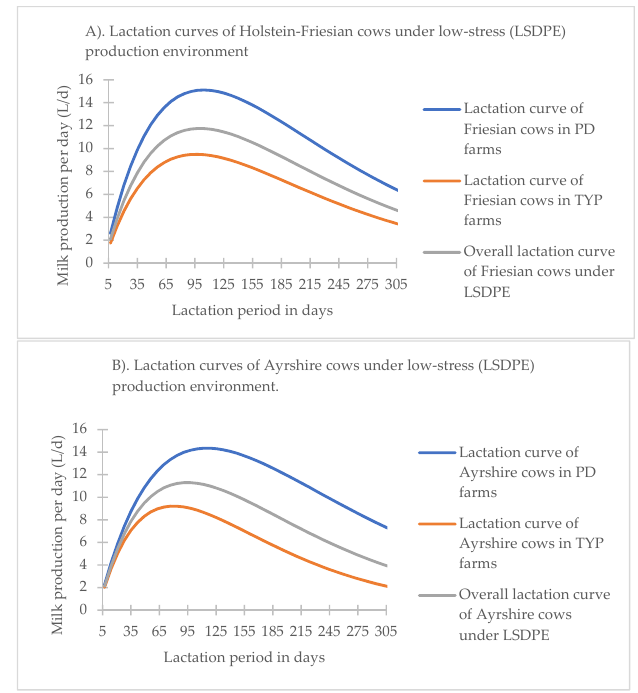
load threshold conditions (68.20 THI units) whereas high-stress environment means mild to mod- heat load stress production environment (77.29 THI units). erate heat load stress production environment (77.29 THI units).